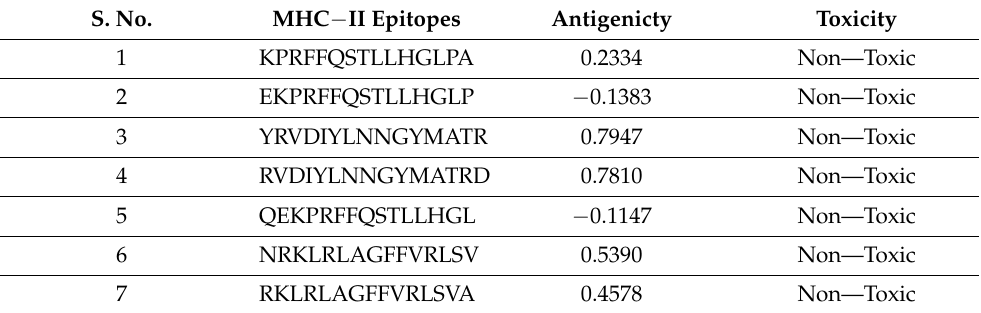
Table 2. MHC-II epitopes.